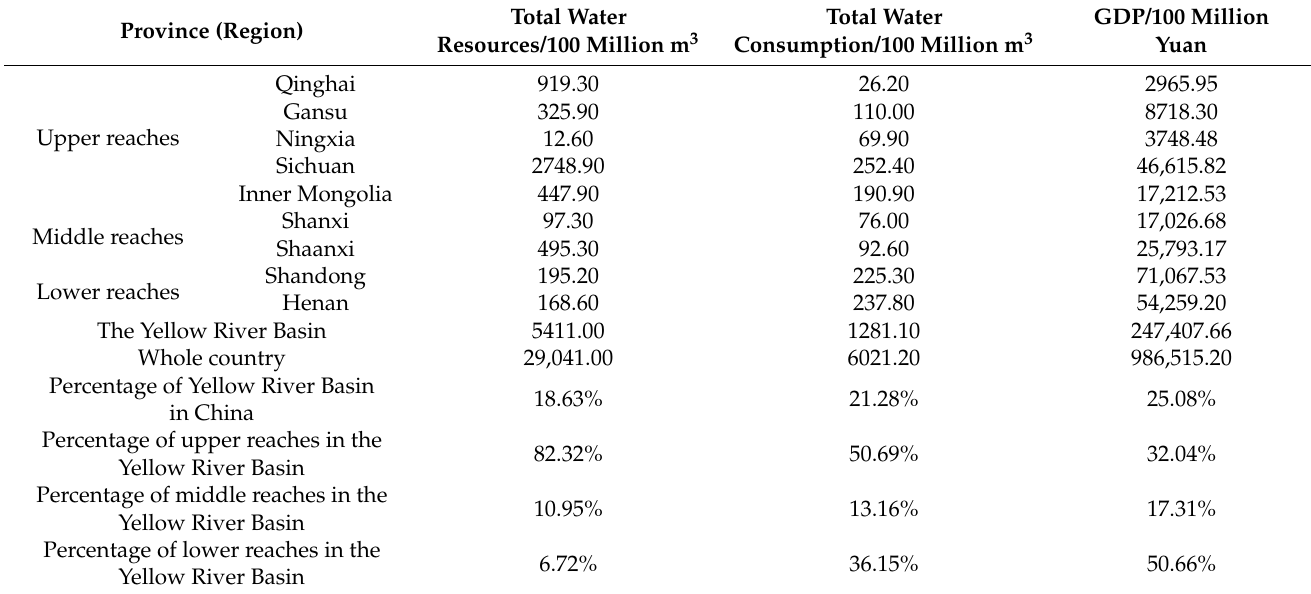
Figure 1. Locations of the upper, middle, and lower reaches of the Yellow River Basin (source: Authors’ own calculation/conception, using ArcGIS 10.7 software (Environmental Systems Research Institute, Inc., Taiyuan, China)). Table 1. Water Resources and economic development of the Yellow River Basin in 2019 (source: China Statistical Yearbook (2020) and China Water Resources Bulletin